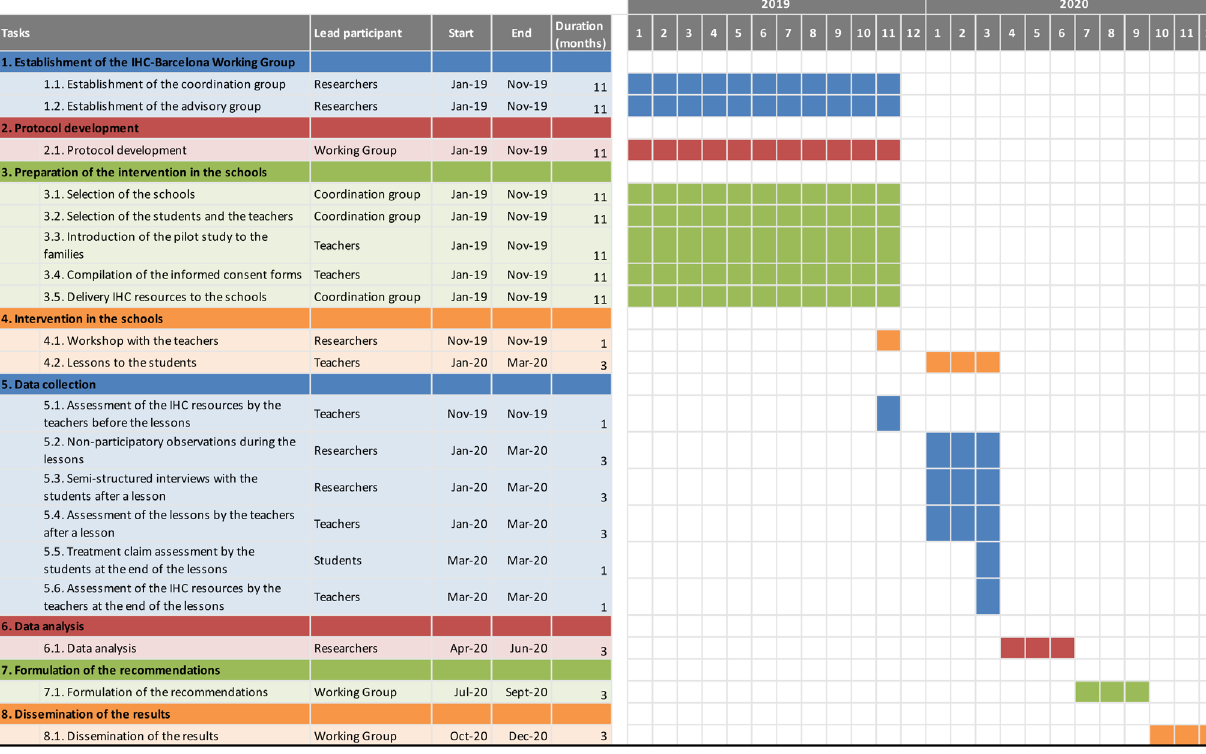
Figure 2. Gantt chart of the pilot